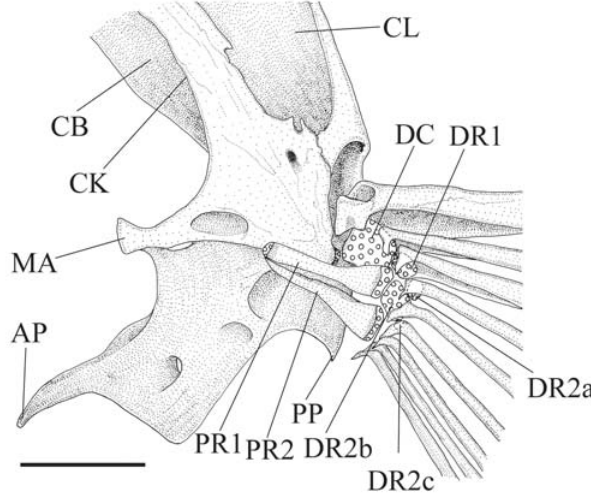
Fig. 9. Basal region of left pectoral fin and proximate portions of pectoral girdle of Rhamdiopsis krugi , LIRP 5928, 33.9 mm SL, paratype. Ventral view. AP ) articular cleithral process; CB ) posterior